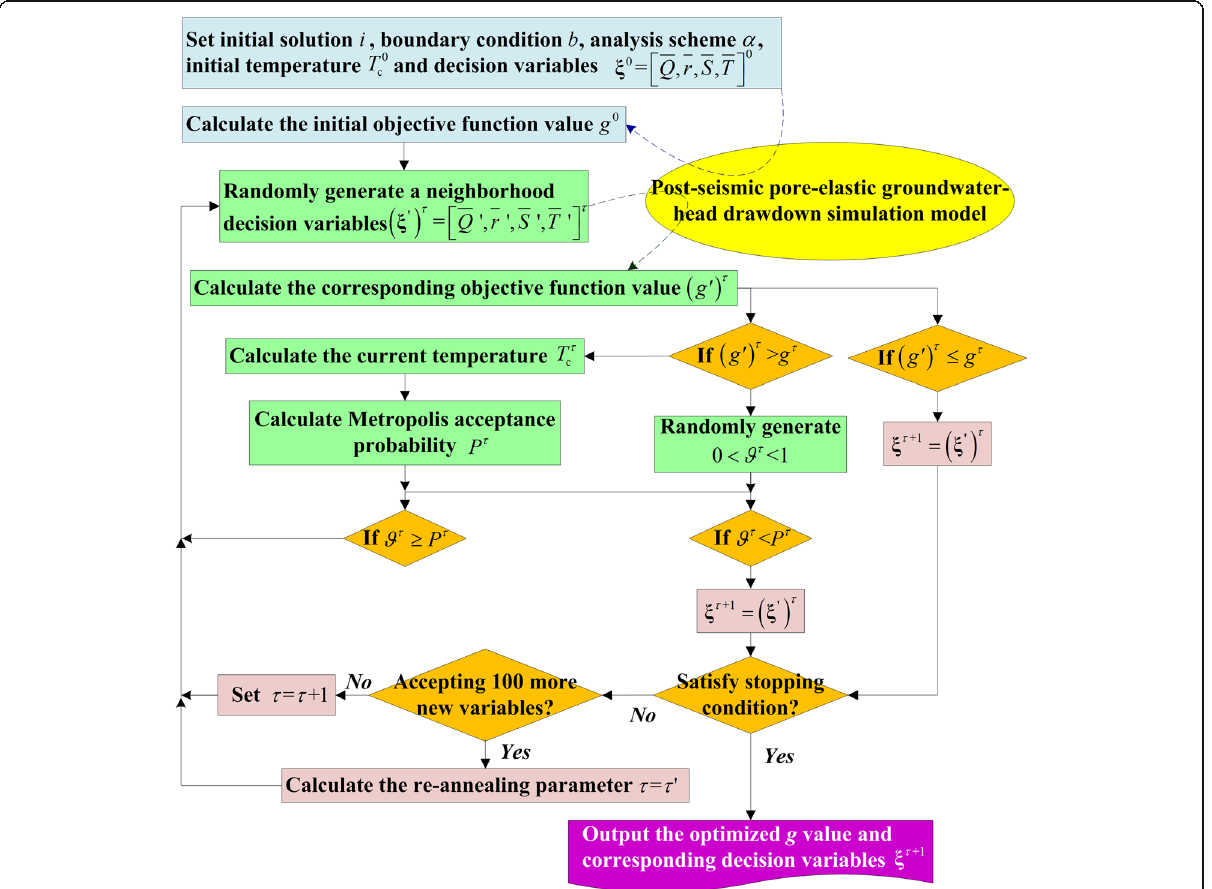
Fig. 3 The flowchart of identifying post-seismic hydrogeological evolution using simulated annealing